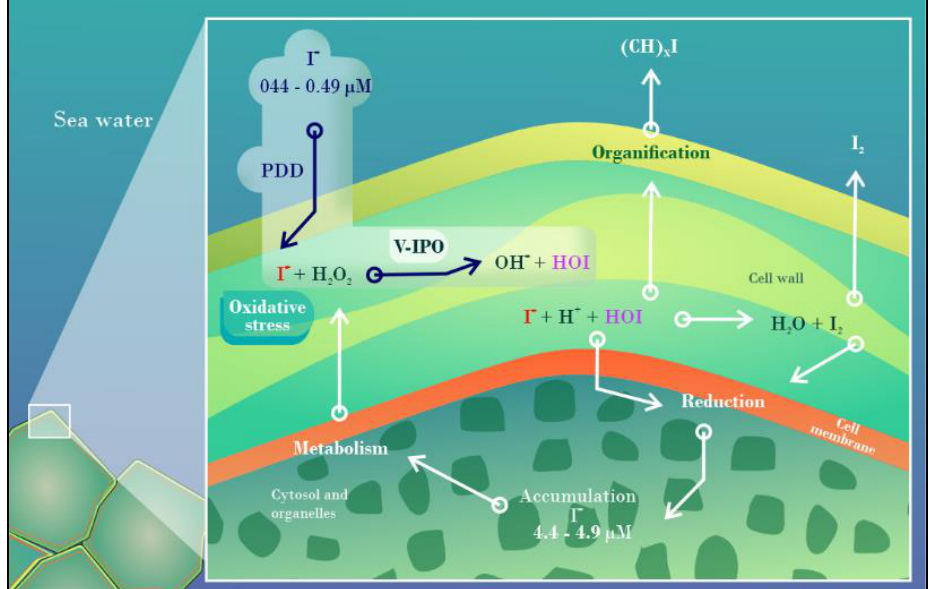
Figure 5. Iodine metabolism in brown algae. In the seawater Laminaria digitata, iodine uptake comprises the active transportation of I − through H 2 O 2 reduction in the cell wall by a V-IPO enzyme (adapted from [145], Frontiers Media, 2016). Intracellularly, I − can be transformed into different inorganic species (such as HIO and I 2 ) and organic forms (mostly methylated forms). Abbreviations: HIO, hypoiodous acid; I − , iodide ion; I 2 , molecular iodine; PDD, hydrogen peroxide-dependent diffusion; V-IPO, vanadium iodoperoxidase.